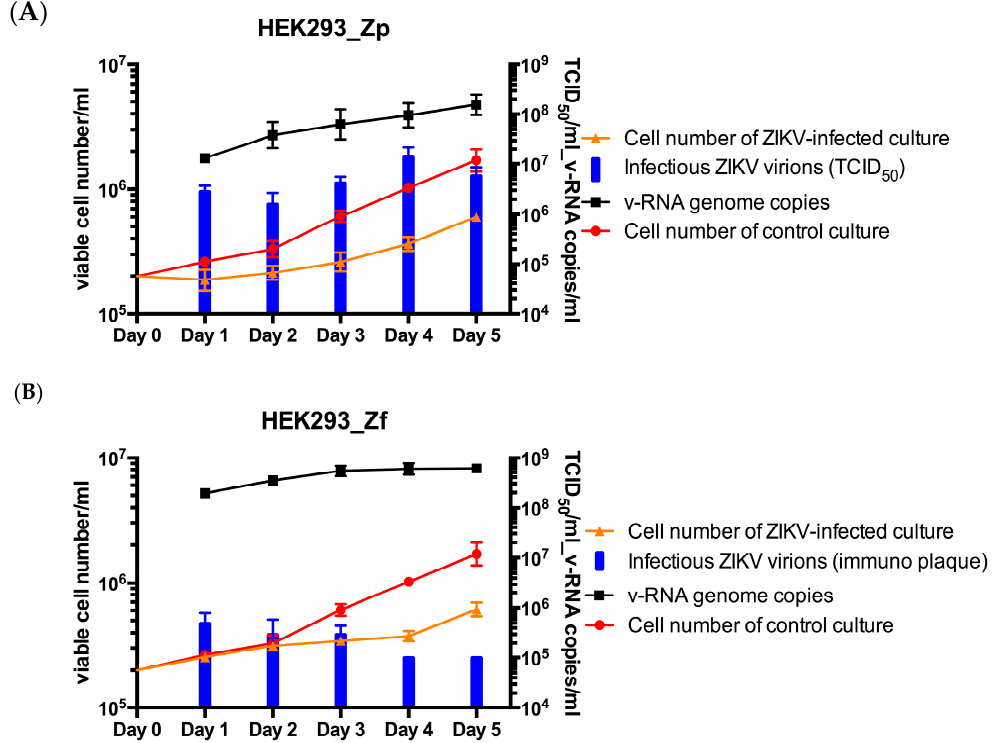
Figure 5. Cell growth, production of ZIKV v-RNA genomes and infectious virions. Panel ( A ) HEK_Zp and panel ( B ) HEK_Zf persistently PRV and FLR strains of ZIKV-infected HEK293 cell cultures. Viable cells were determined by trypan blue dye exclusion. Quantitation of v-RNA ZIKV genomes by RT-PCR and titration of infectious ZIKV virions using the TCID50 assay (immune plaque assay for HEK293_Zf cell cultures) were done using samples collected daily from the supernatants of infected HEK293 cell cultures. The error bars represent the triplicate for each measurement conducted at each time point of the study.